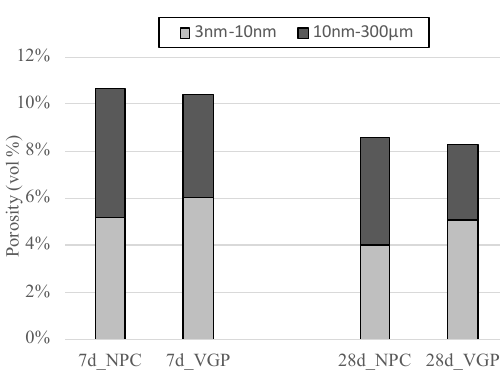
Figure 14. Compressive strength (W/B=0.4).